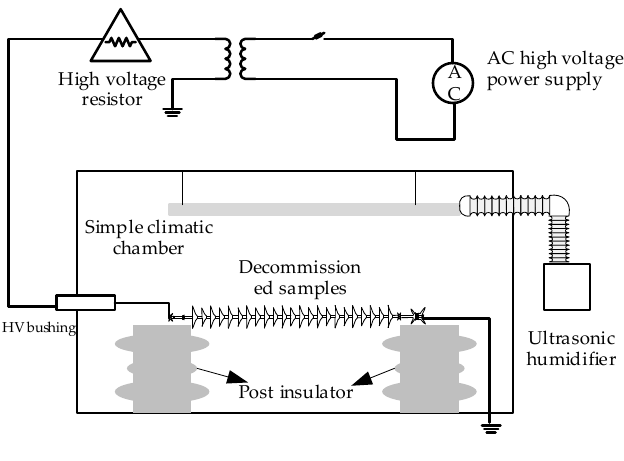
Figure 3. Test Figure 3. Test layout.